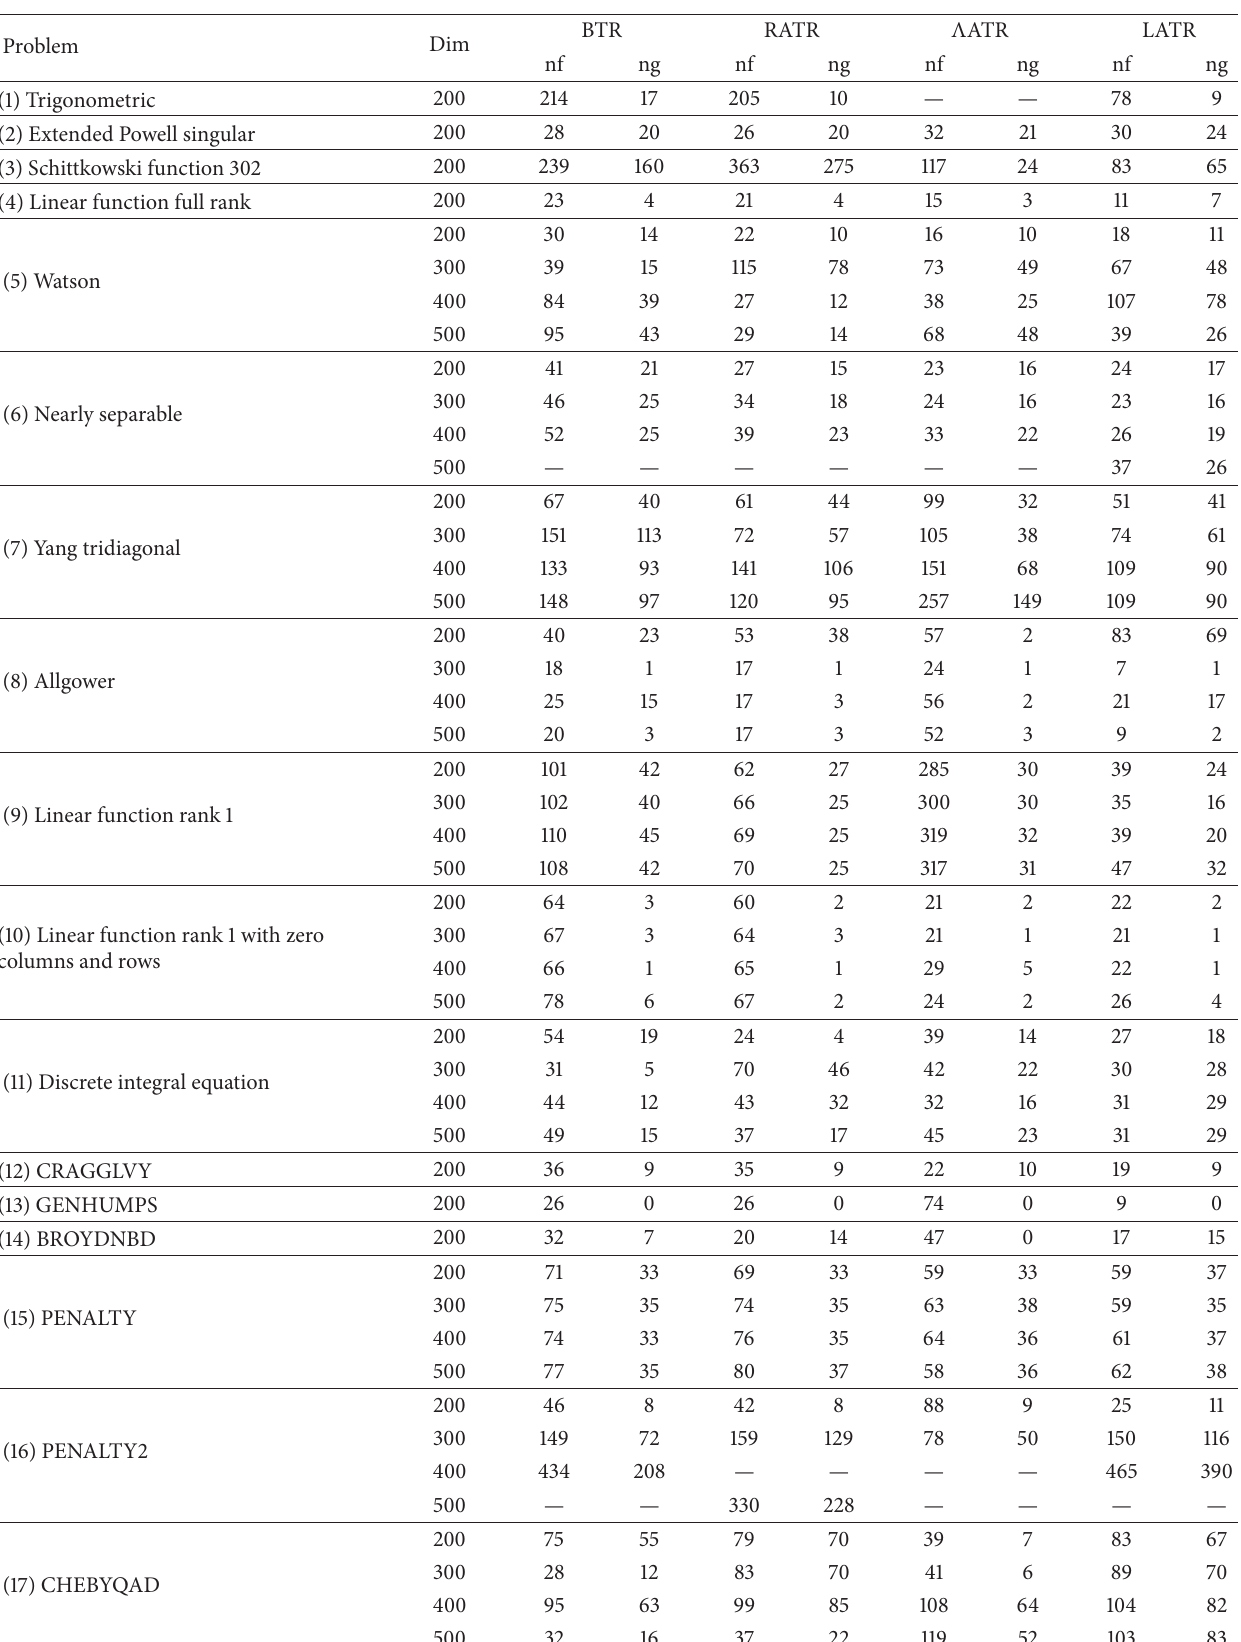
Table 1: Numerical comparisons of BTR, RATR, Λ ATR, and